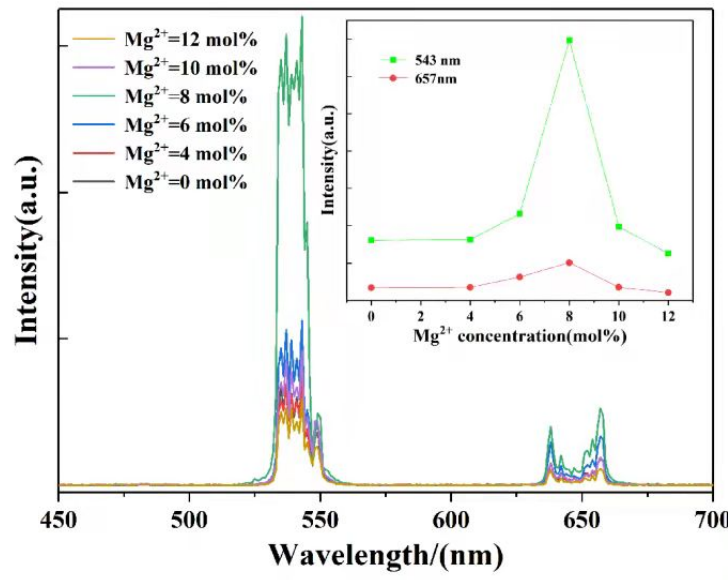
Figure 3. Photoluminescence spectra of LiYF 4 :Yb 3+ /Ho 3+ UCMPs with different Mg 2+ doping concentrations.